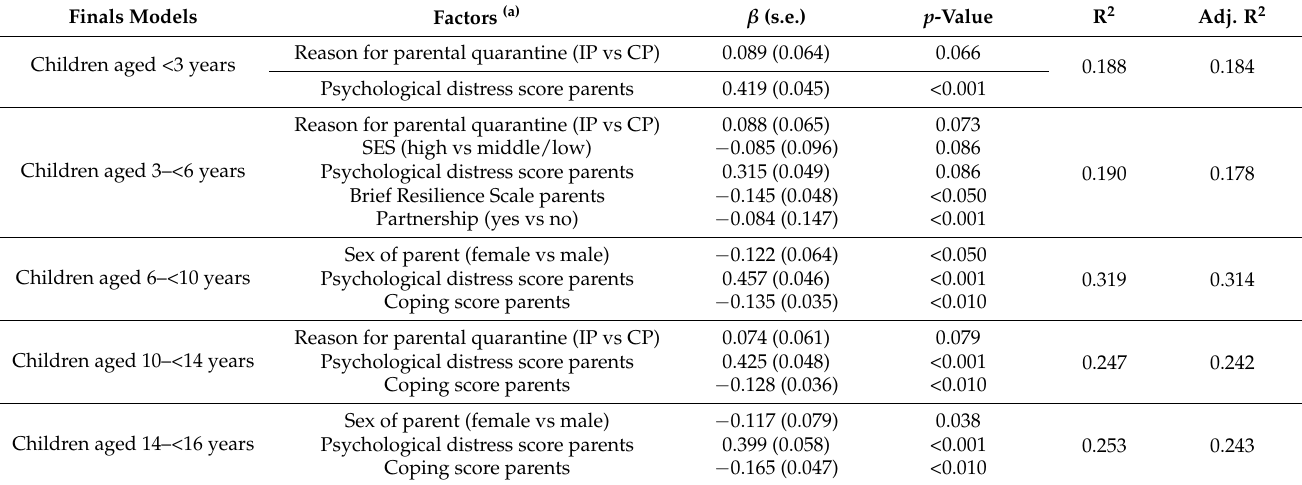
Table 4. Final models in multiple linear regressions in terms of children’s relative sum